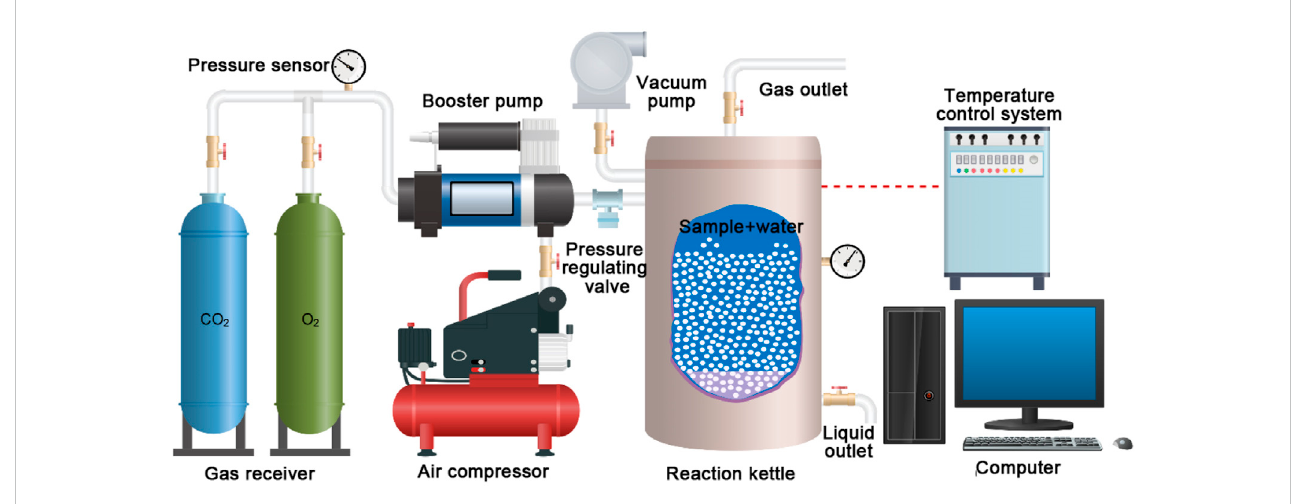
FIGURE 3 Schematic diagram of gas – liquid – solid high-temperature/pressure